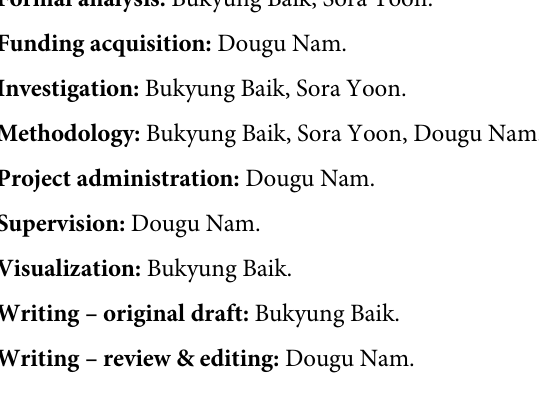
S13 Fig. Similarity of DE analysis methods. Hierarchical clustering of DE genes based on spearman rank correlation. The union of top 3000 and 300 DE genes obtained from 12 DE analysis methods were clustered between different methods based on spearman rank correla- tion for (A) KIRC and (B) Bottomly datasets,